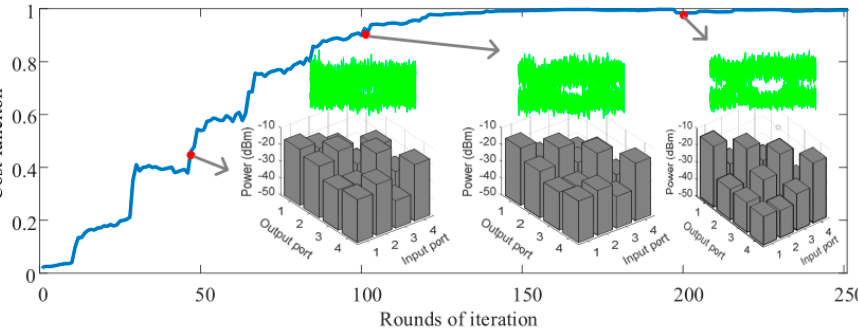
Figure 10. Results of algorithm training [42]. Three different training times are selected with 50 times,100 times and 200 times.